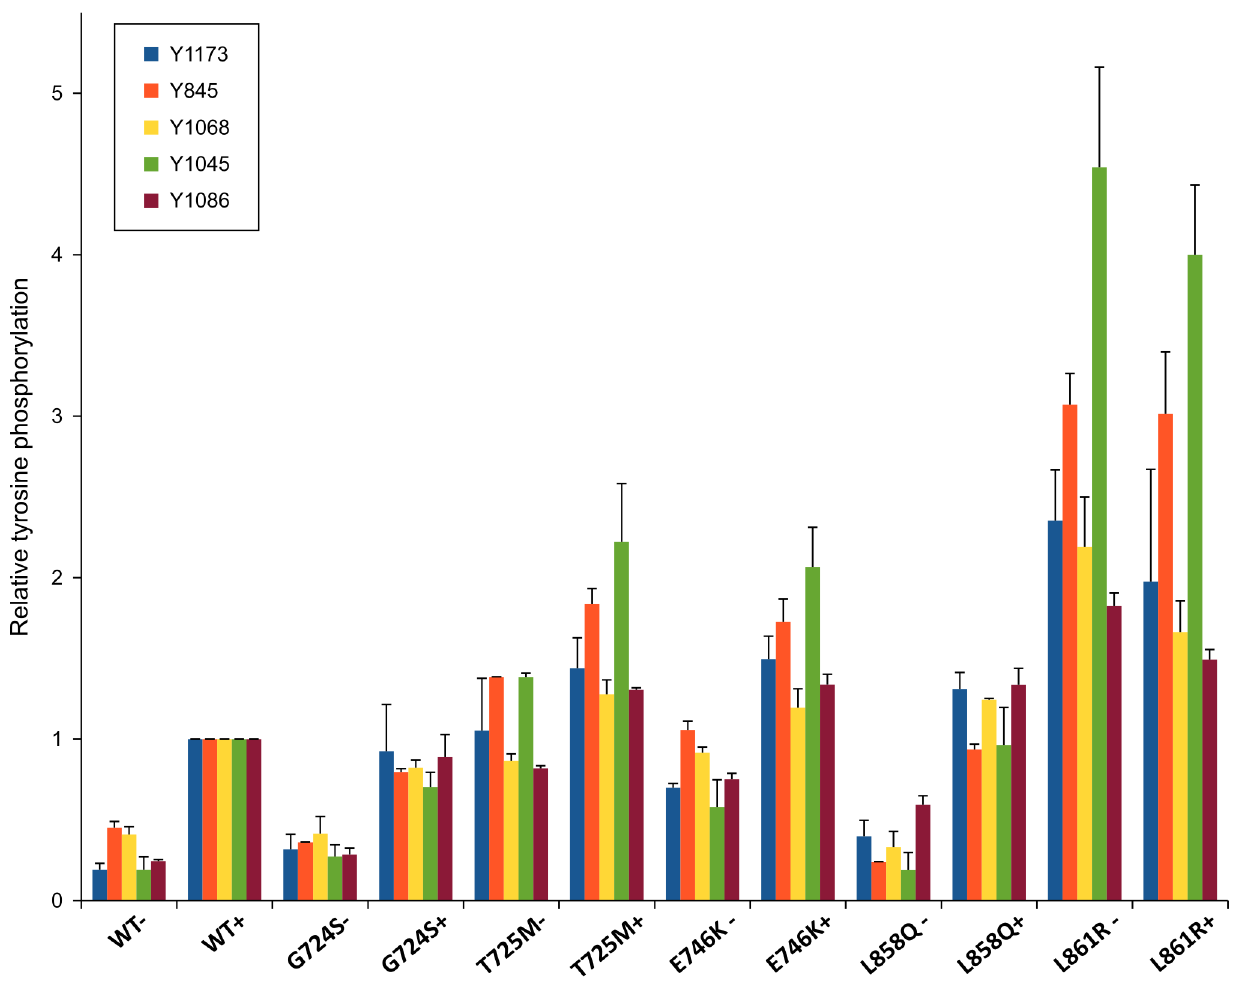
Figure 3. Quantified tyrosine auto-phosphorylation levels of wild-type and mutant-type EGFR. Quantified phosphorylation levels are shown in the form of histograms. Quantification was done using Image J.